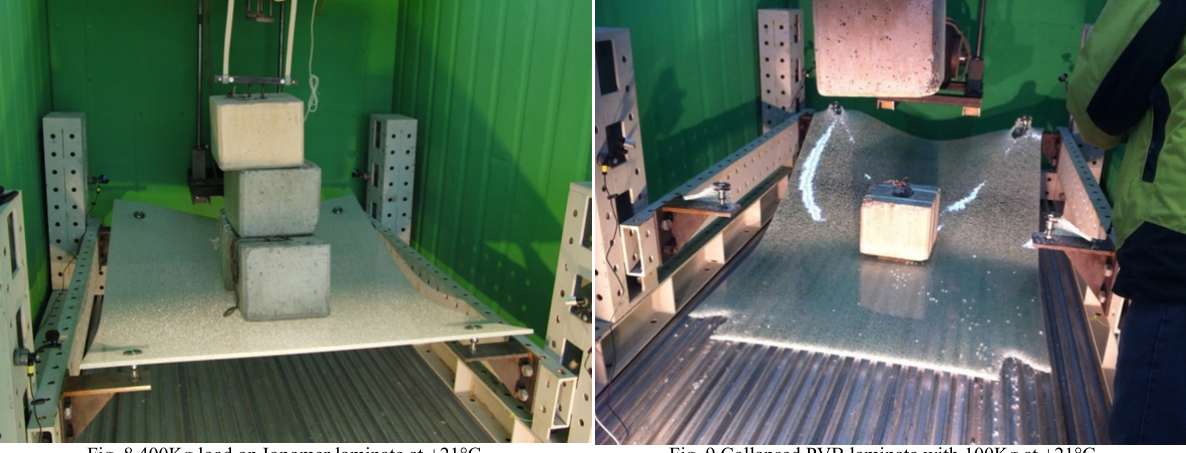
Fig. 8 400Kg load on Ionomer laminate at +21°C Fig. 9 Collapsed PVB laminate with 100Kg at +21°C